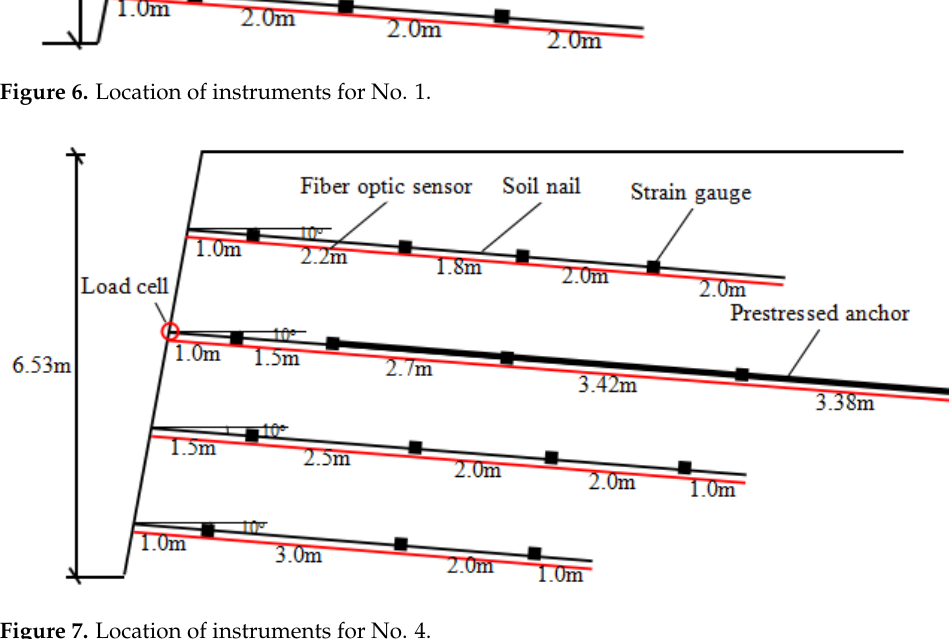
Figure 7. Location of instruments for No. 4.